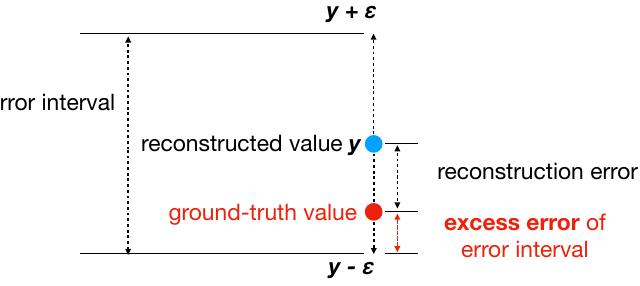
Figure 8. Notion of excess error of the error